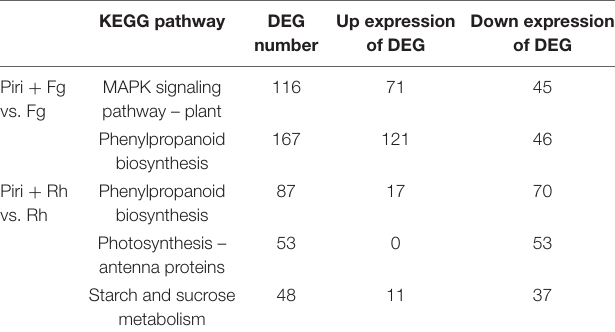
TABLE 3 | Differentially expressed genes (DEG) involved in the key KEGG pathway in the comparison group of Piri + Fg vs. Fg and Piri + Rh vs. Rh. KEGG pathway DEG Up expression Down expression number of DEG of DEG Piri + Fg vs.